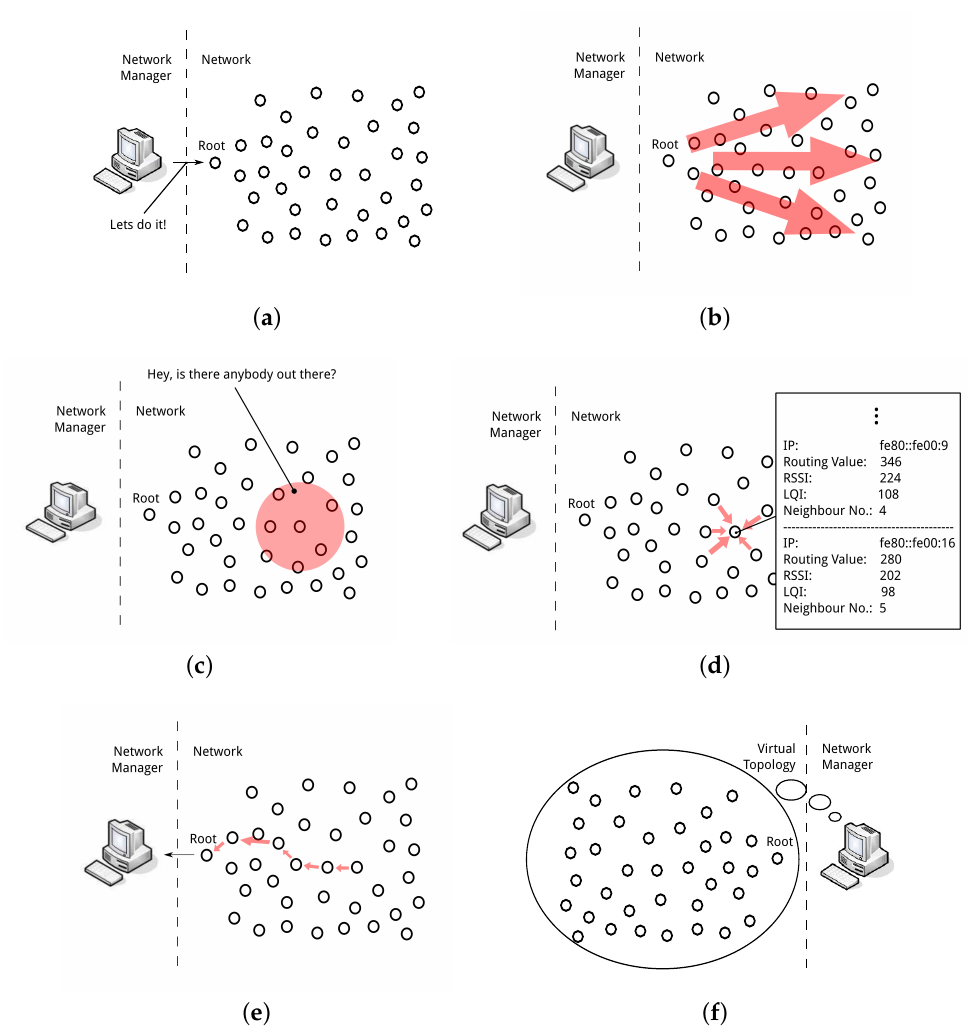
Figure 5. Information gathering process instigated by network manager. ( a ) The network manager sends a message to the root of the network instigating the information gathering process; ( b ) The root relays this message to all nodes in the network; ( c ) Each node in the network sends out a beacon requesting information from its neighbours; ( d ) The neighbouring nodes send a reply and a neighbour list is generated with physical link information included; ( e ) Each node in the network sends its neighbour list back to the root of the network and this information is then passed to the network manager; ( f ) The network manager maintains a virtual topology with the network information from which it can extract the physical